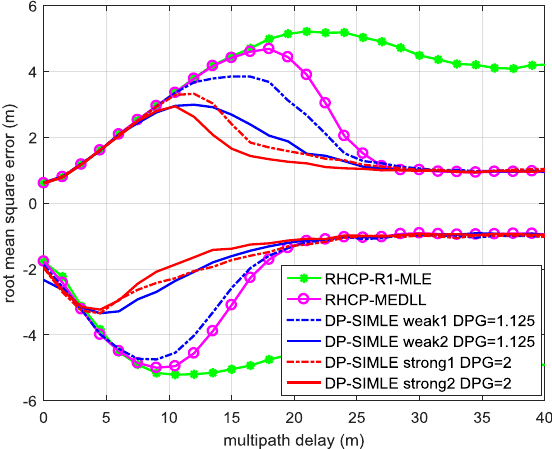
Figure 7. The RMSEs of the TOA estimation of the LOS signal using DP-SIMLE algorithm in different received signal cases defined by Table 2. The lines above zero are the results when constructive multipath is present, and the lines below zeros are that of the destructive multipath. The simulation parameters are the same with that in Section 3. In RHCP channel, the power of the MP signal is 6 dB less than the LOS signal; the CNR is 42 dB-Hz and the integration time is 100 ms.